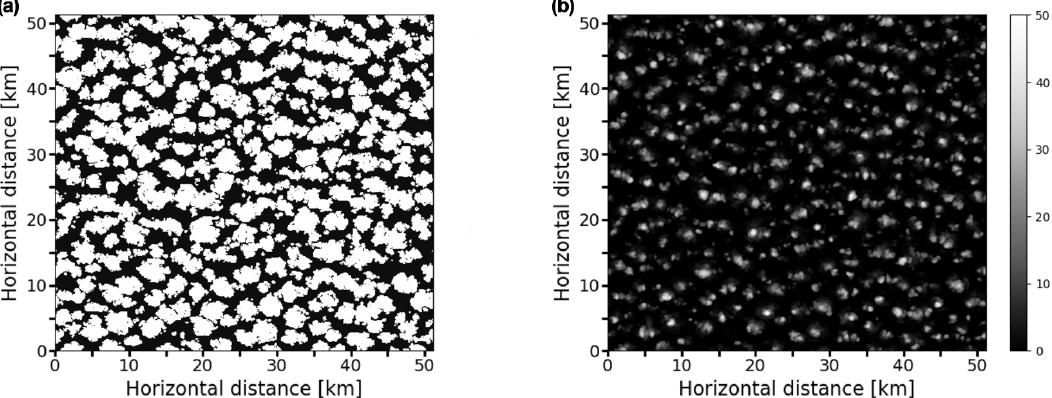
Figure 3. Horizontal heterogeneity for shallow cumulus cloud field. (a) Cloud mask (clouds in white; clear sky in black). (b) Vertically integrated cloud optical thickness in the visible spectral range, highlighting solely optically thicker convective